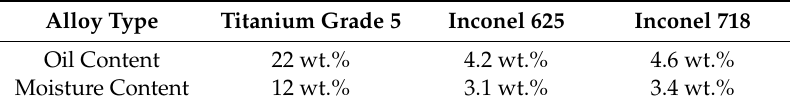
Table 2. Respective values for physical analysis of swarf materials.